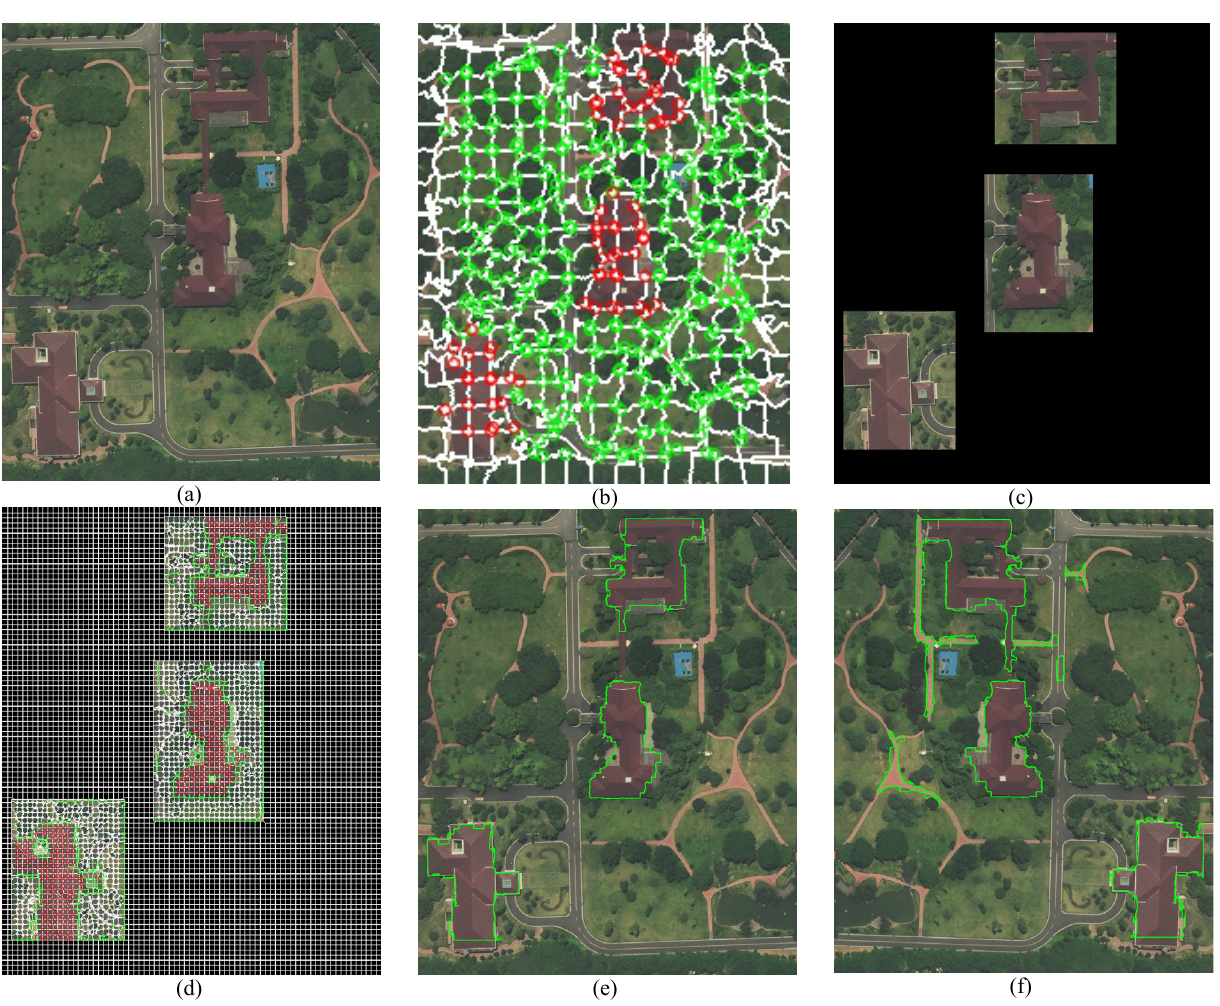
Figure 2: For image 2, (a) The original image; (b) Result of extracted intersections; (c) Result of building area detection; (d) Result of extracted intersections from detected building area; (e) Result of building contours extraction using ORB+BBOF; (f) Result of building contours extraction using SURF+BOF.